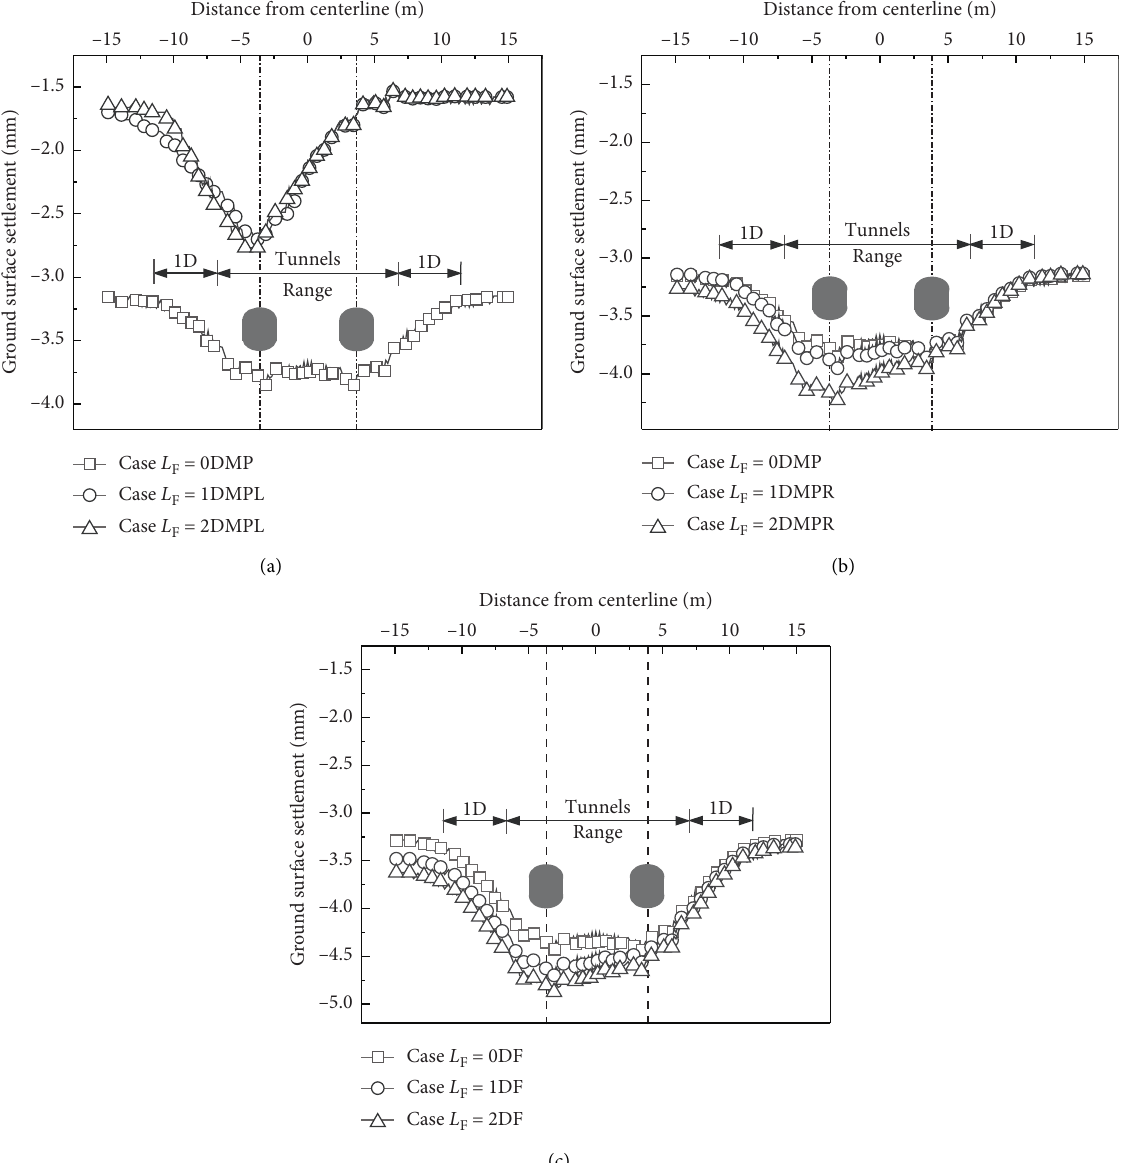
Figure 8: Surface settlement at key construction times while cutting left side of supporting piles, right side of supporting piles, and at construction completion.